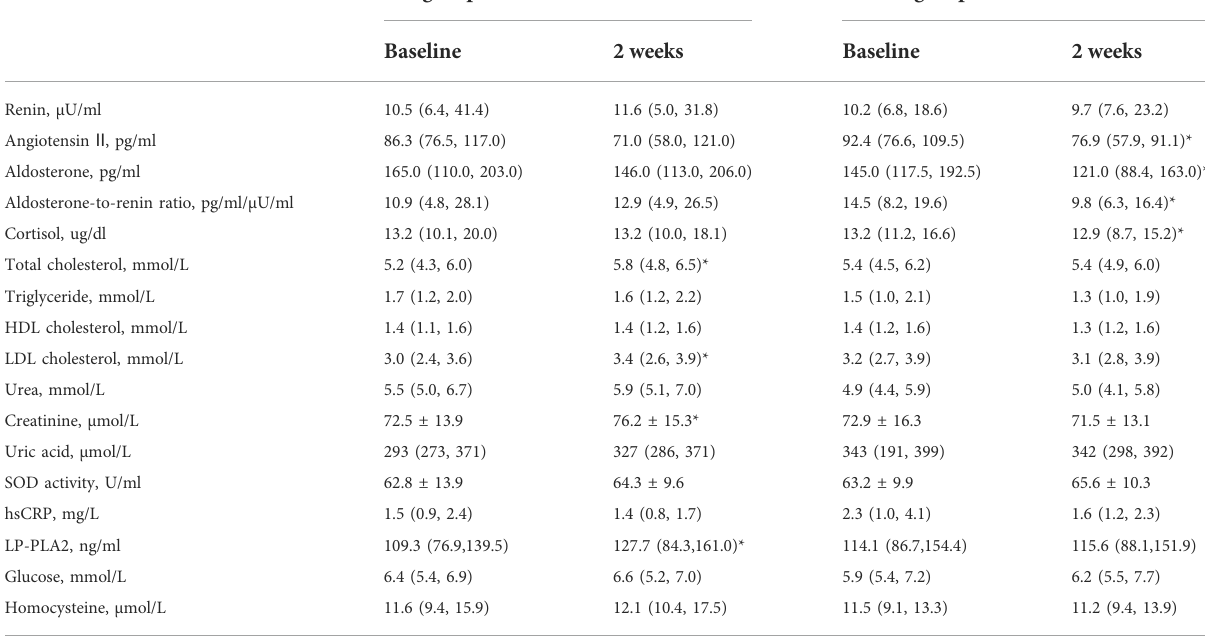
TABLE 3 Plasma biochemical parameters at baseline and after the 2-week